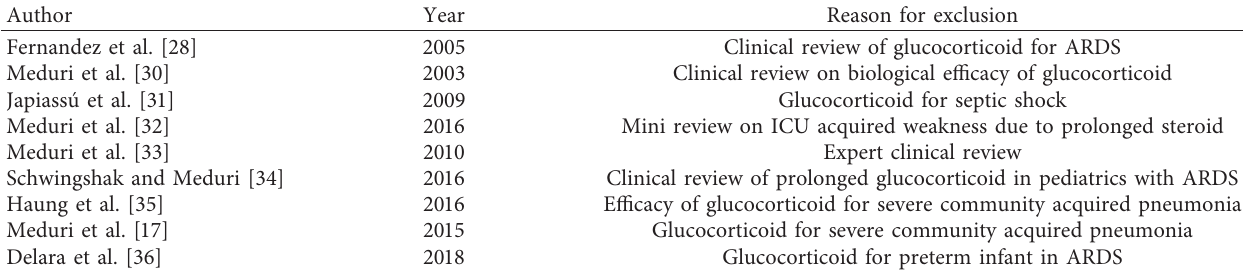
Table 3: Description of excluded